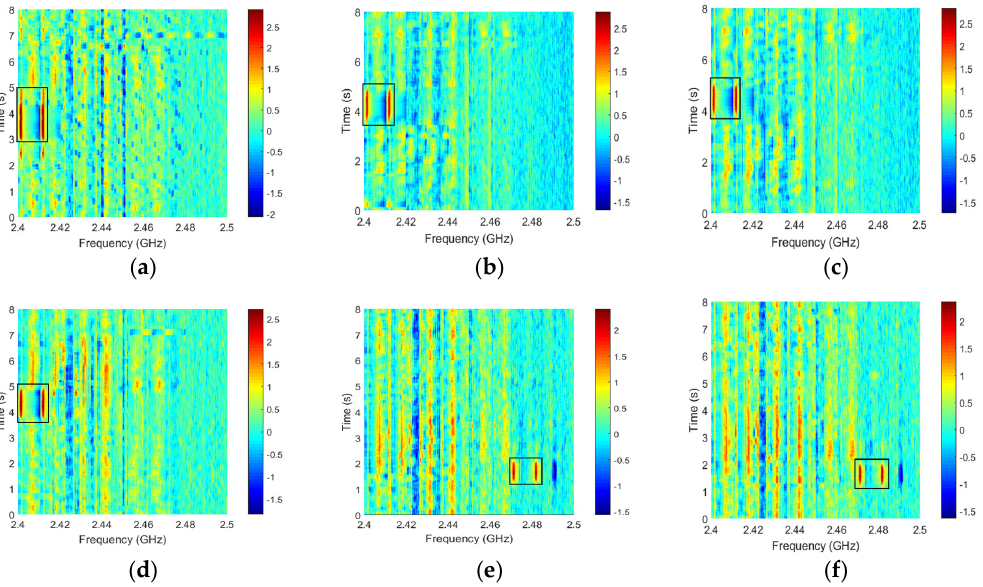
Figure 8. The results for the improved cross-correlation method at outdoor distances of ( a ) 500 m, ( b )